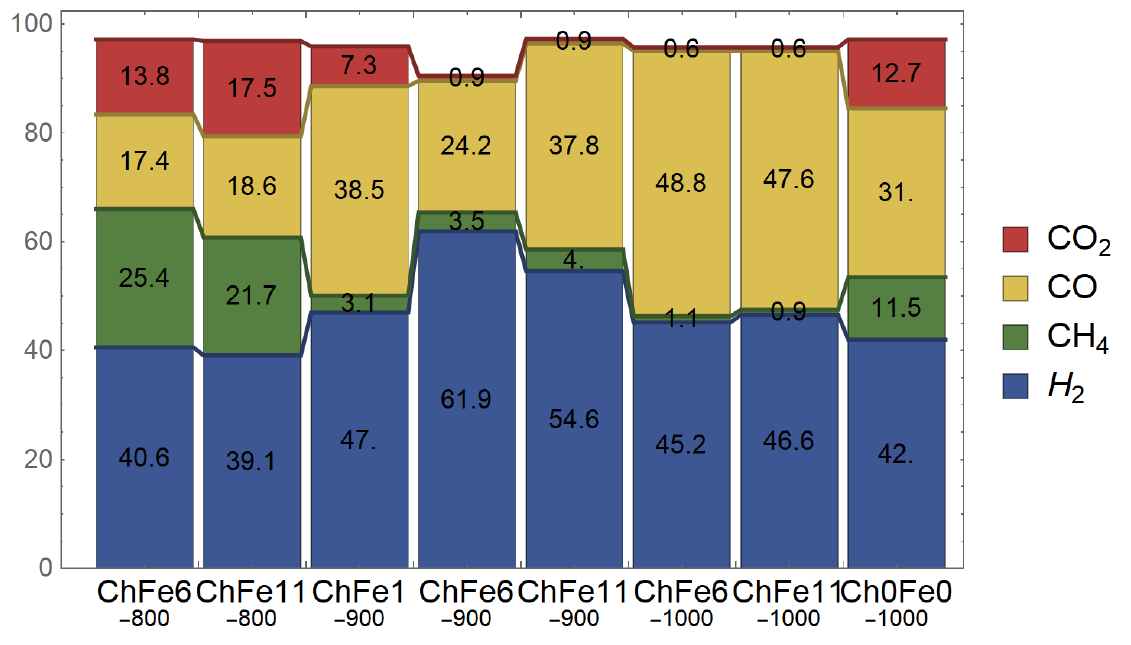
Figure 3. Gas composition (vol%) after RDF pyrolysis for different cases.